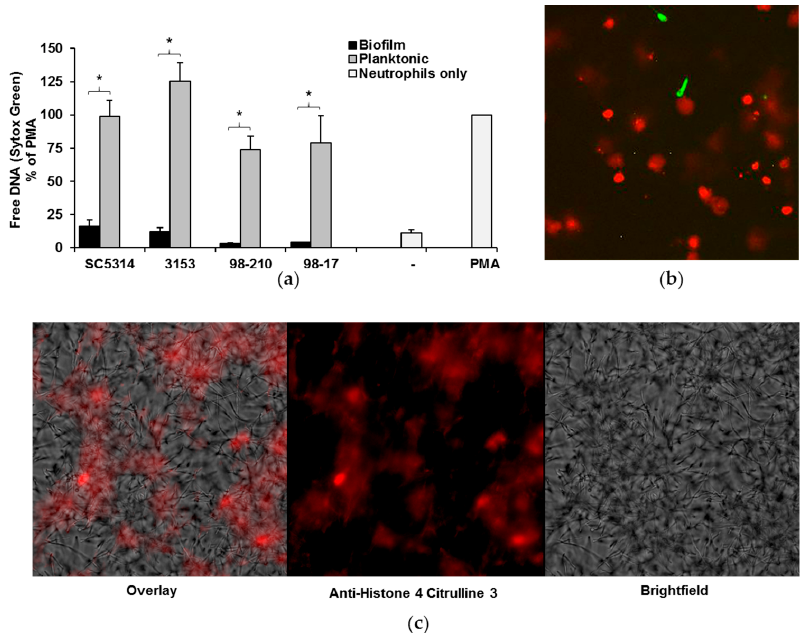
Figure 4. NET release by neutrophils exposed to C. albicans clinical strains. ( a ) Neutrophils were co-cultured with planktonic cells or biofilms for 4 h, and NET release was measured with a Sytox Green fluorescence assay. Neutrophils alone (-) served as a negative control, and neutrophils stimulated with PMA were included as a positive control and for normalization. The release of NETs upon encounter with biofilm and planktonic organisms for each strain was compared using a Student’s t -test, * p < 0.05, n = 5, SEM shown. ( b ) In order to visualize free DNA following neutrophil co-culture with planktonic C. albicans , neutrophils were pre-stained with Calcein AM (green) and co-incubated with planktonic cells (SC5314) for 4 h. After staining with propidium iodide (red), images were taken at 20×, and digitally enlarged 2× for comparison. ( c ) To assess the degree of histone citrullination, SC5314 planktonic co-cultures were stained with anti-H4 citrulline 3 antibody (red). Images were obtained at 40×.